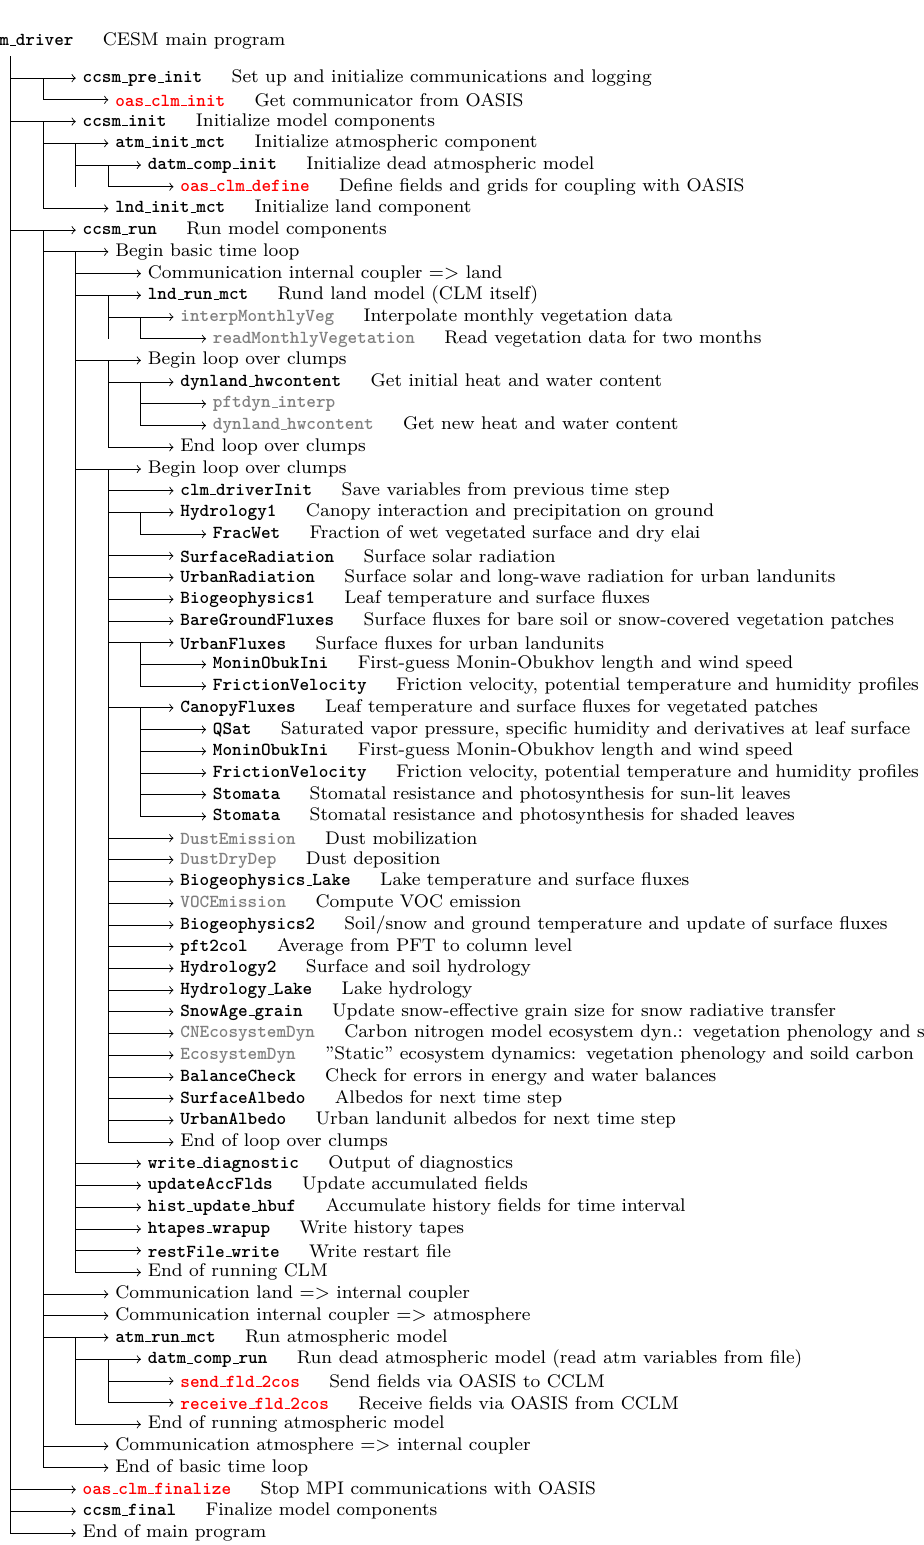
Figure 13. As Fig. 8 but for the Community Land Model (CLM). The grey highlighted routines are optional.